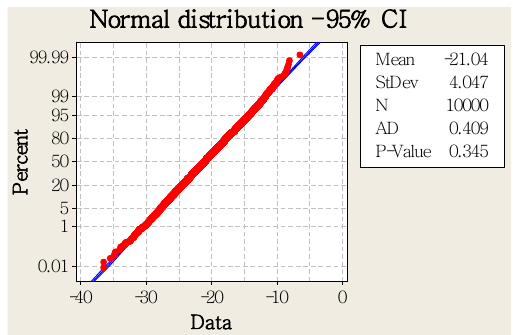
Figure 6. Probability test plot for the Box-Cox transformed total hazard index